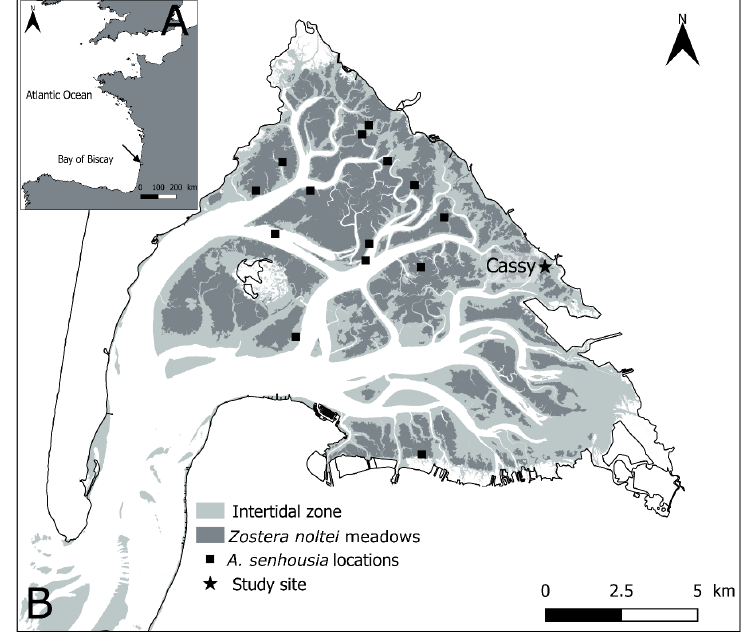
Figure 1. Localization of Arcachon Bay (black arrow) within the French Atlantic coast ( A ) and of the study site (“Cassy”) within the Bay ( B ). Black squares indicate the locations with occurrence of A. senhousia reported by [7].